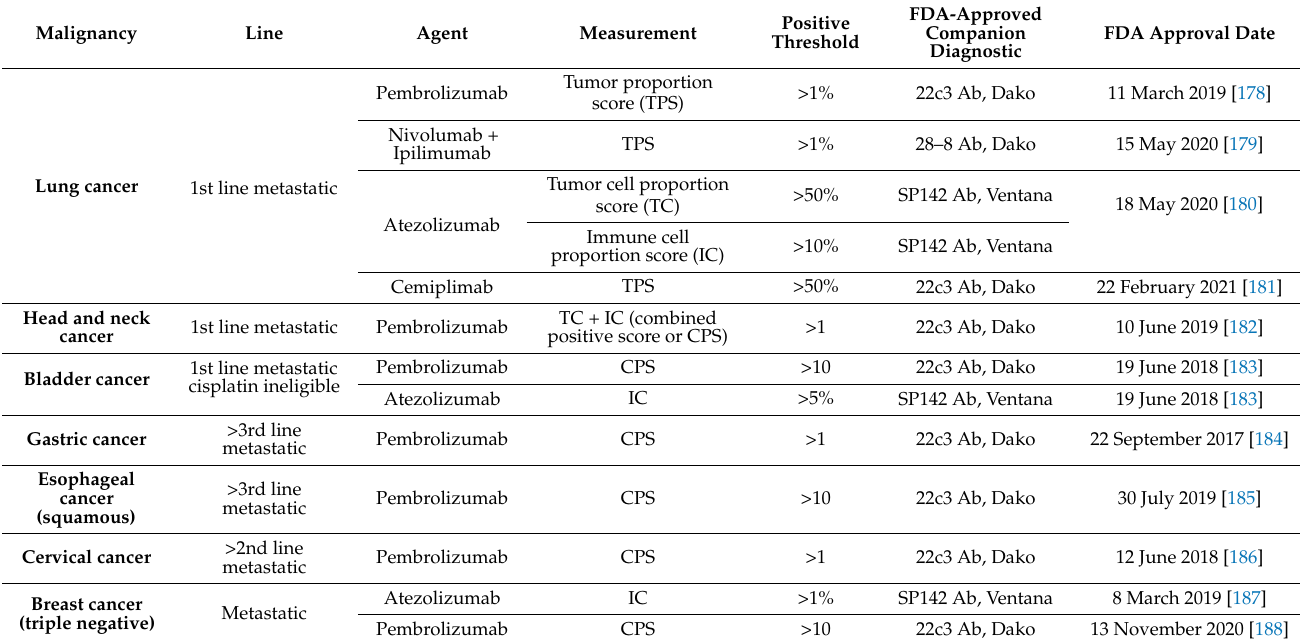
Table 3. Indications for use of PD-1 or PD-L1 antibodies dependent on PD-L1 level.